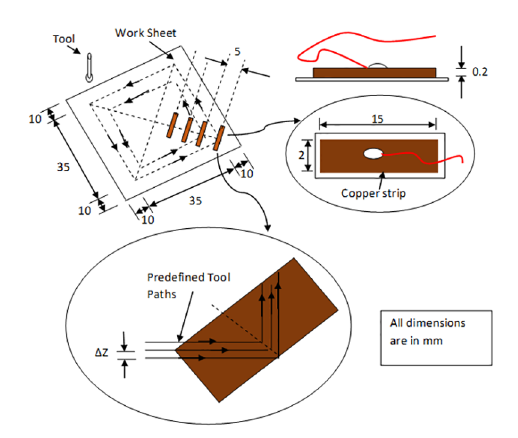
Figure 3. The Schematic diagram of antenna fixation on the sample piece to capture EMR.